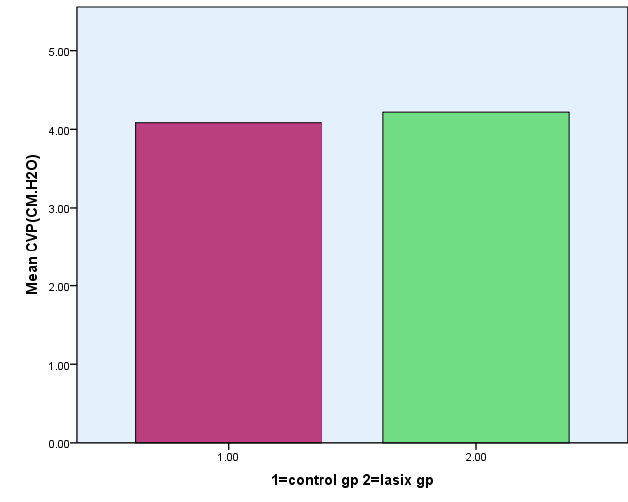
Figure(12A): Shocked patients received normal saline group versus shocked patients received furosemide group,in term of central venous pressure CVP,there is no significant statistical